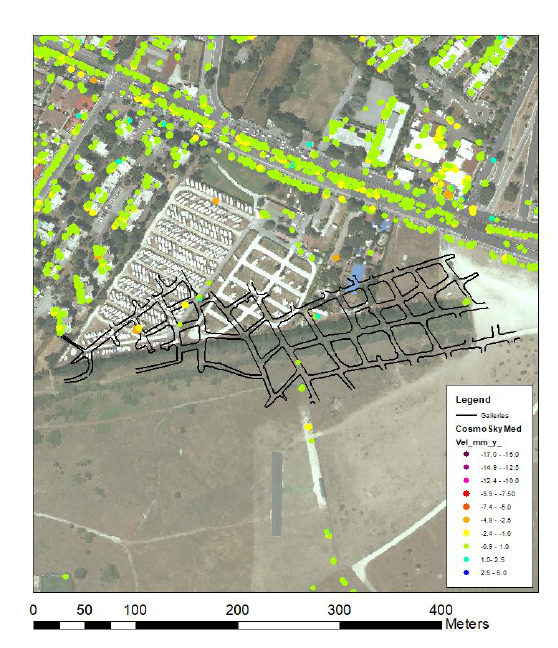
Figure 22. PS shapefile from SAR Cosmo SkyMed dataset (2010-2015) zoomed on the area of the galleries in Centocelle Park (vectorization of the planimetry (Mecchia & Piro,